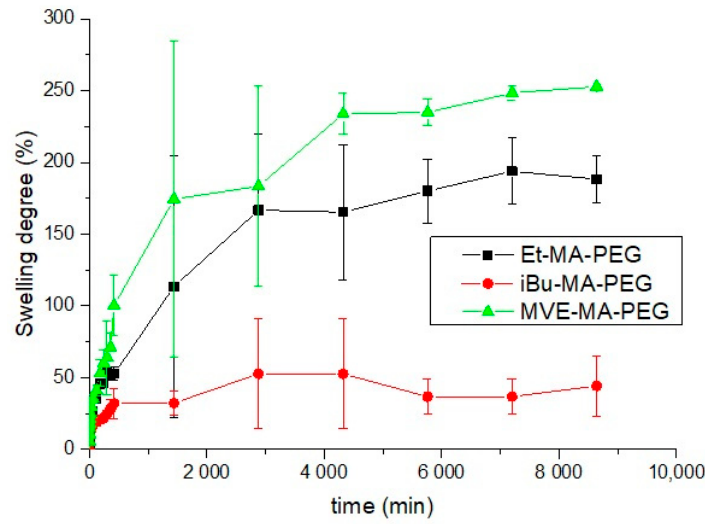
Figure 3. Swelling degree of the copolymers hydrogels in water.